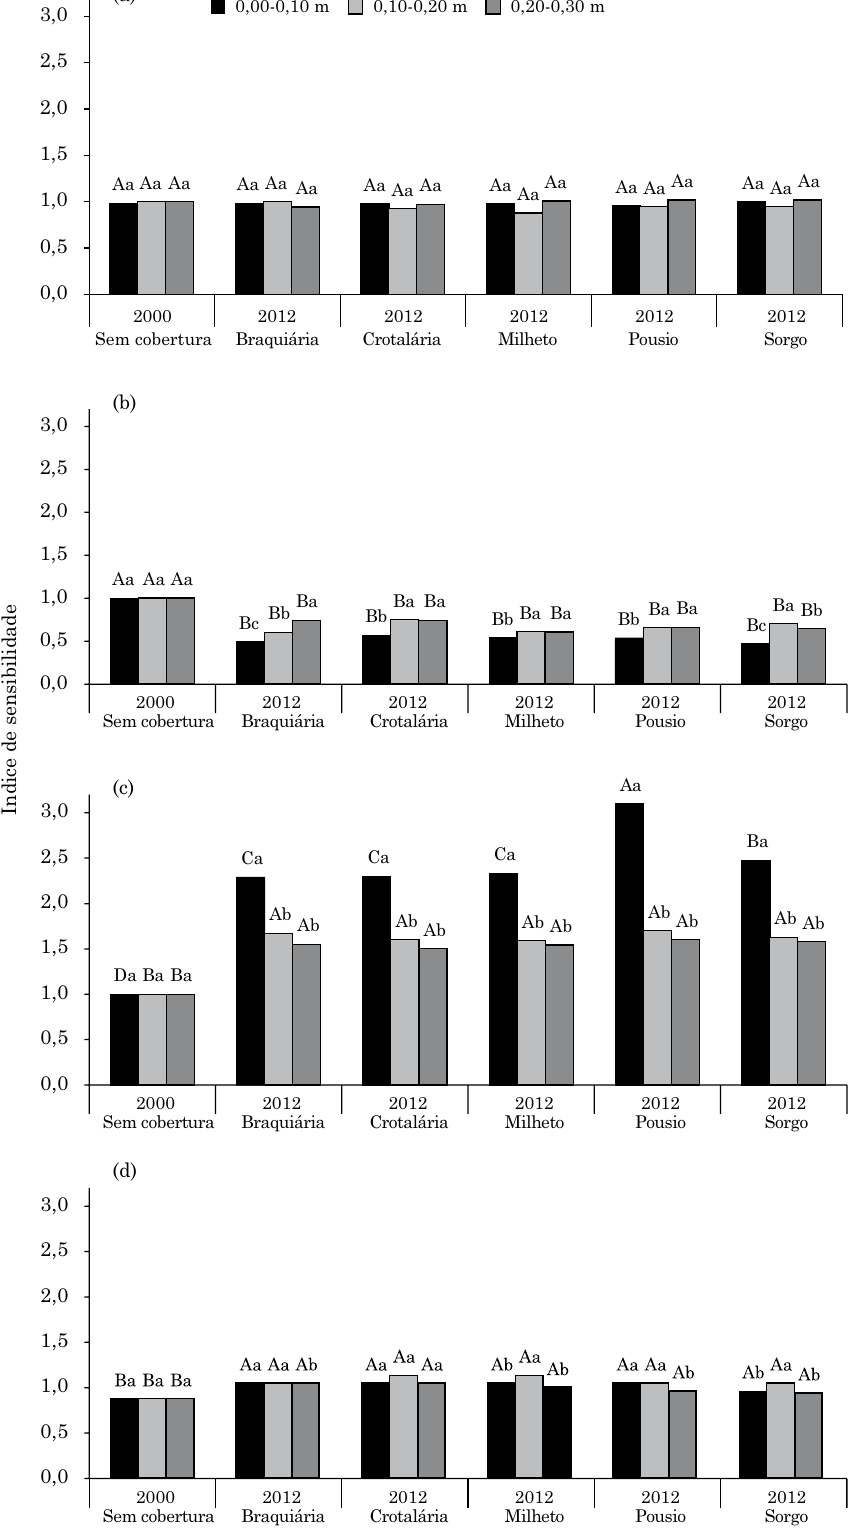
Figura 1. Índice de sensibilidade (Is) para densidade do solo (a), macroporosidade (b), microporosidade (c) e porosidade total (d), em Latossolo Vermelho distrófico. Médias seguidas de mesmas letras maiúsculas comparam coberturas nas mesmas profundidades, assim como as minúsculas comparam profundidades dentro das coberturas avaliadas e não diferem entre si pelo teste de Tukey